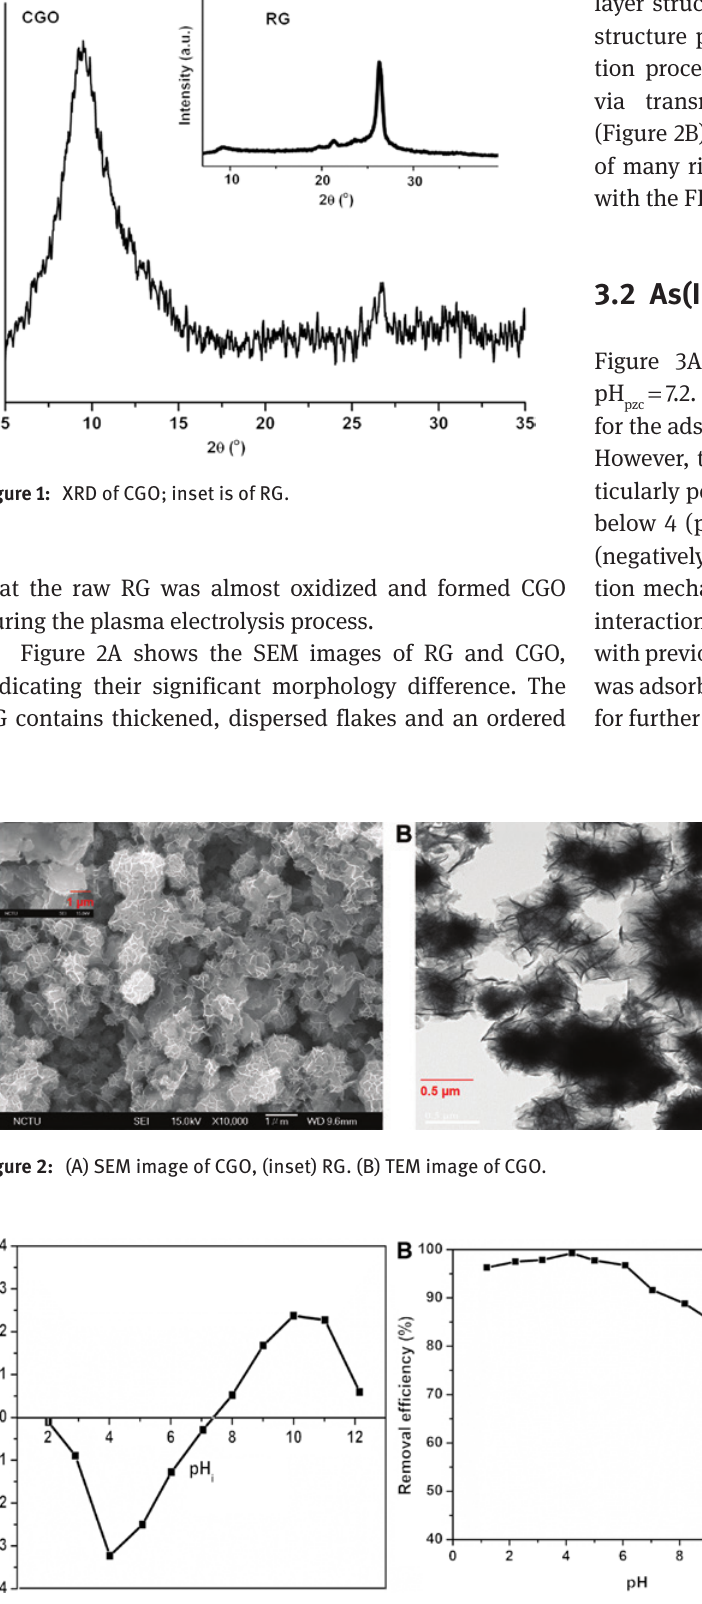
of the CGO and (B) effect of pH on the adsorption of Figure 3: (A) The pH pzc